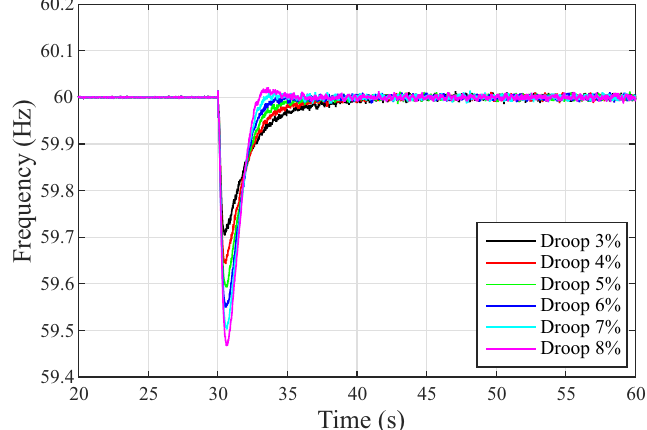
Figure 8. Frequency behavior with variation of the droop value for a wind speed of 14